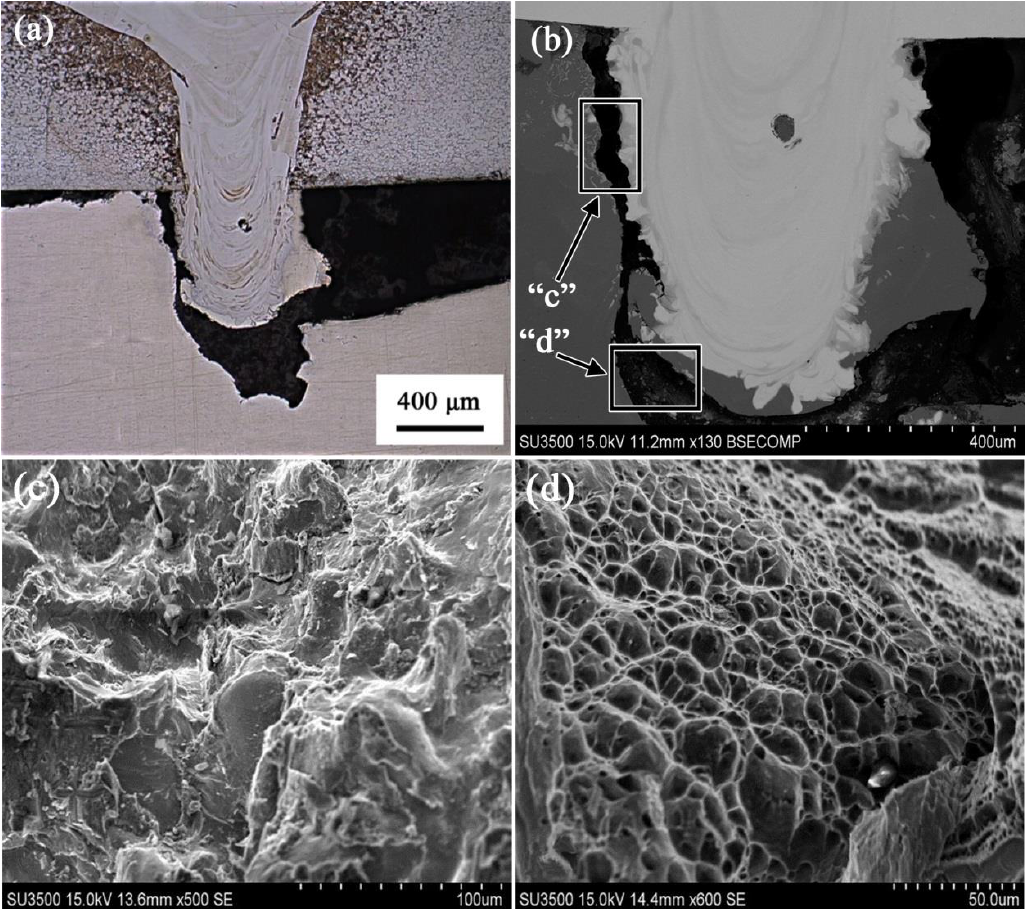
Figure 13. Fracture path morphology of steel/Al joints with an optimum P2 of 477 μm produced by dual-beam laser welding with side-by-side configuration: ( a ) Macroscopic fractured steel/Al joint; ( b ) BSE image of enlarged view of fracture path; ( c ) SEM image of fracture surface of Zone “c”; ( d ) SEM image of fracture surface of Zone “ d ”.